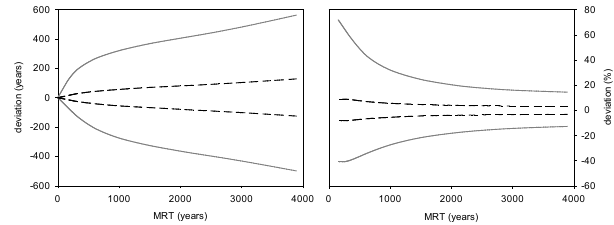
Figure 3. Comparison of absolute (left) and relative (right) devi- ation of calculated MRTs from the mean, expressed as 95% con- fidence interval of (i) average analytical errors (inner, dashed line) and (ii) average experimental variability in the field (outer, solid lines). In the ZOFE trial, MRTs of below 200 years resemble top- soil 0–20cm, those of ca. 1200 years resemble 30–60cm, and those of ca. 2600 years resemble